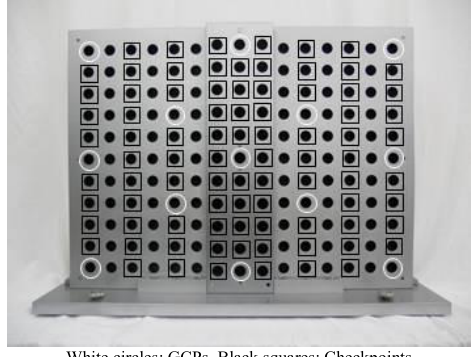
White circles: GCPs, Black squares: Checkpoints Figure 2. Test target